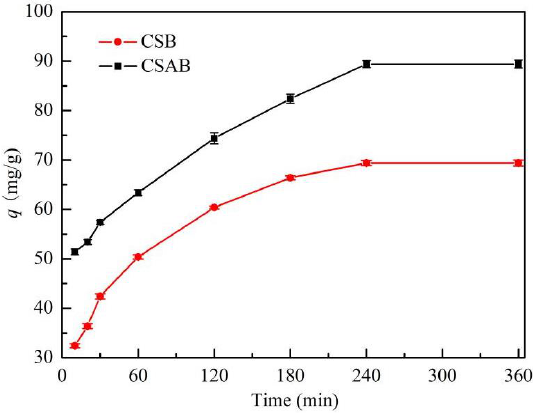
Figure 8. Effect of contact time on the adsorption of diesel oil onto biochar.